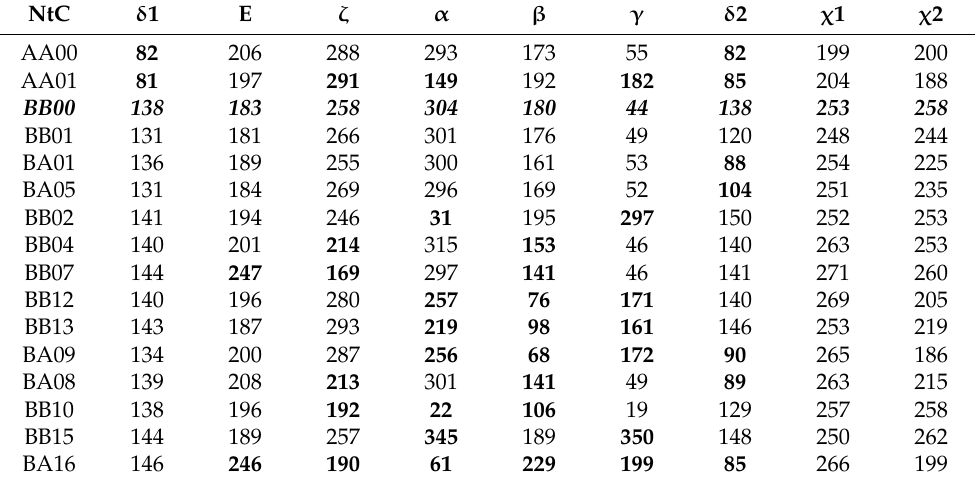
Table 1. Torsion angles of select conformational classes (NtCs, [13]) of the minimal fragments of the DNA chain considered in this